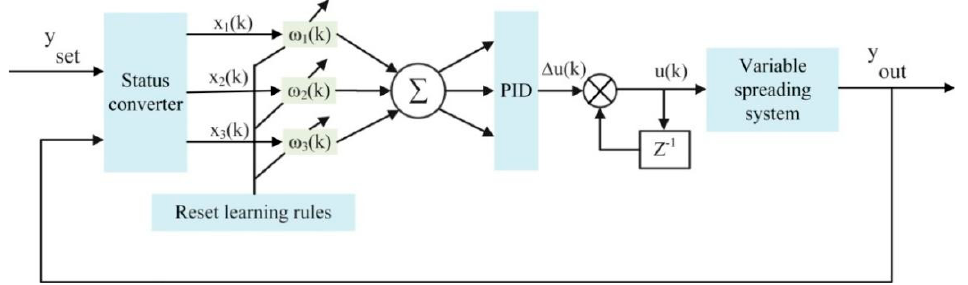
Figure 5. Block diagram of adaptive SNPID control system based on weighted coefficient learning correction.